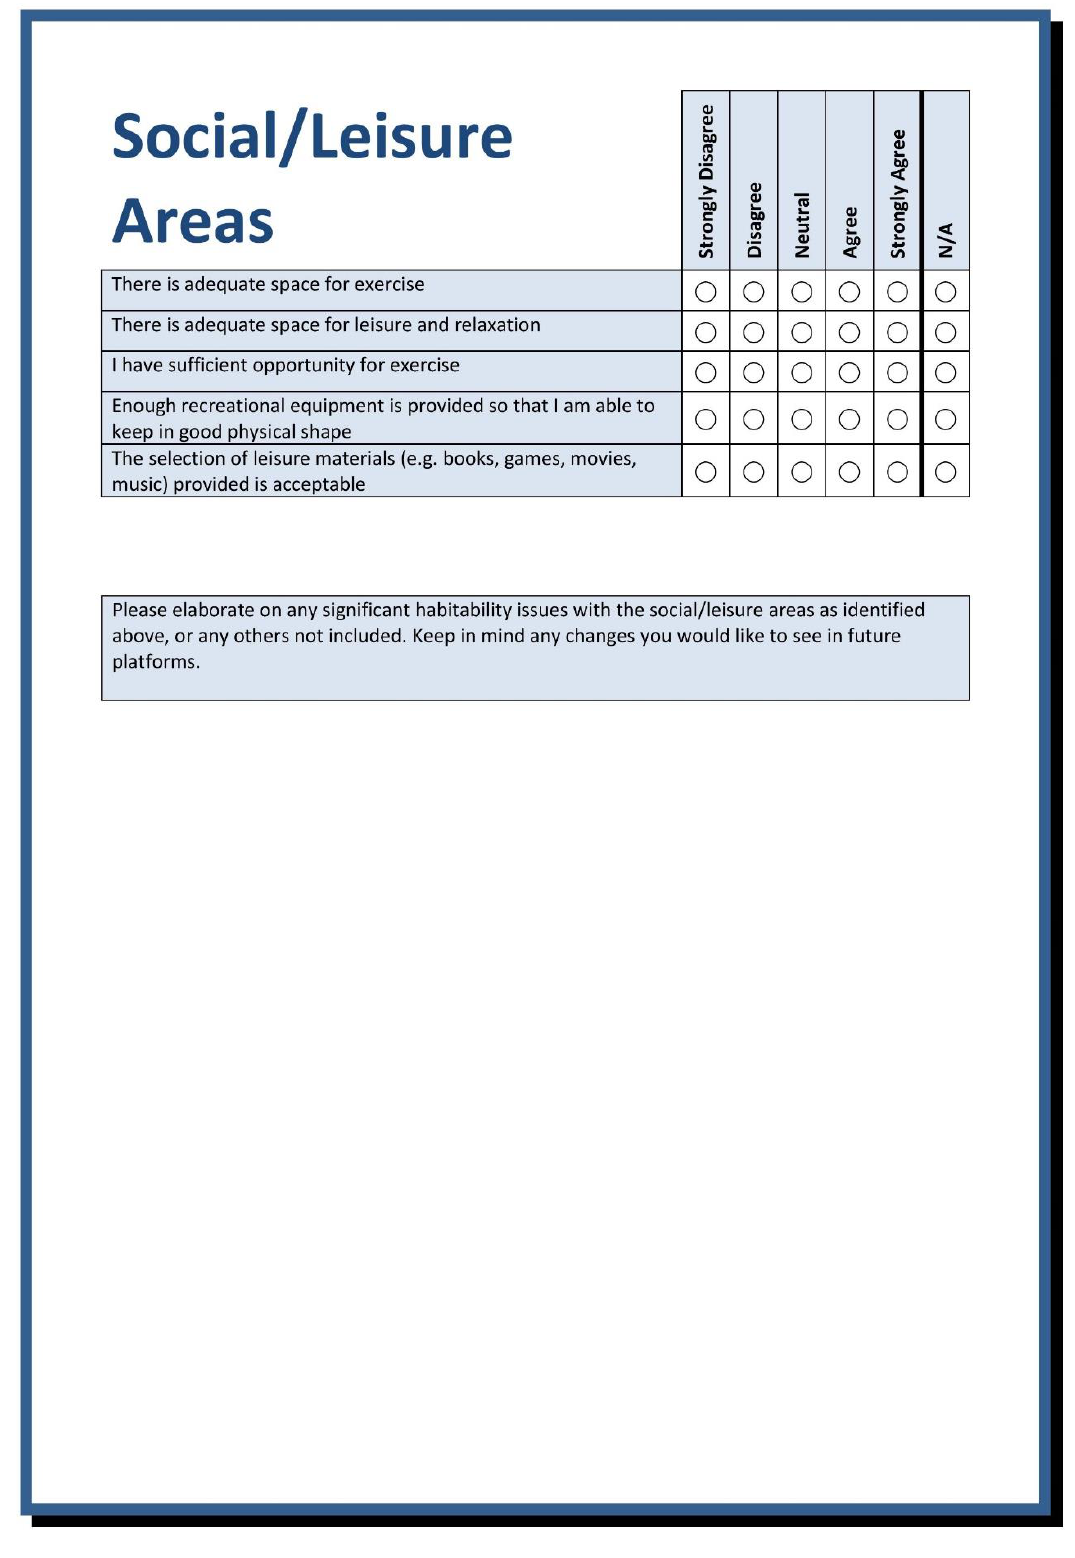
Figure A12. The Submarine Habitability Assessment Questionnaire (continued).